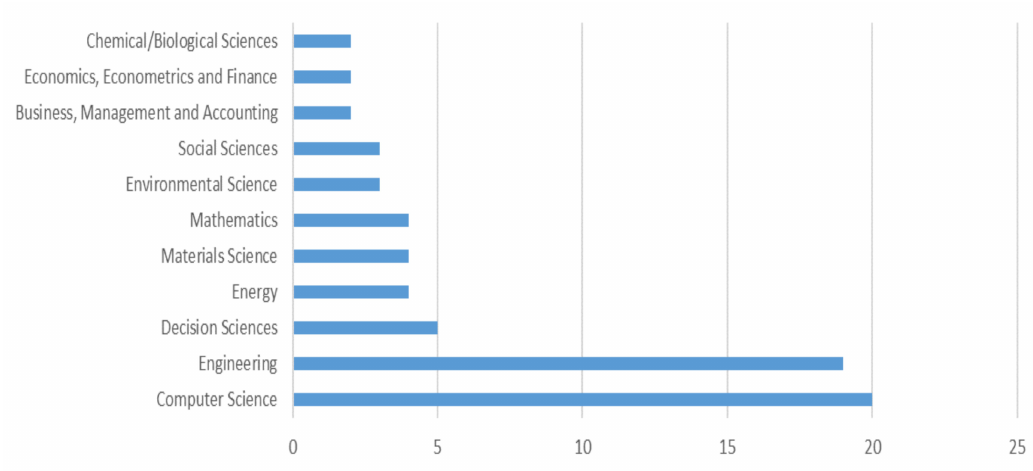
Figure 9. Publication by subject area (source: Scopus).